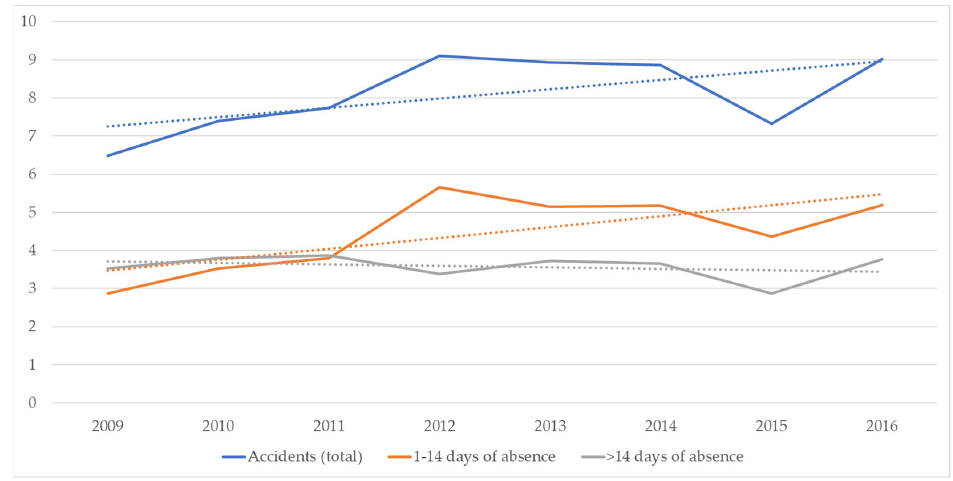
Figure 10 . Incidence rates in demolition. Based on data from [17 – 24,27] . Figure 10. Incidence rates in demolition. Based on data from [17–24,27].